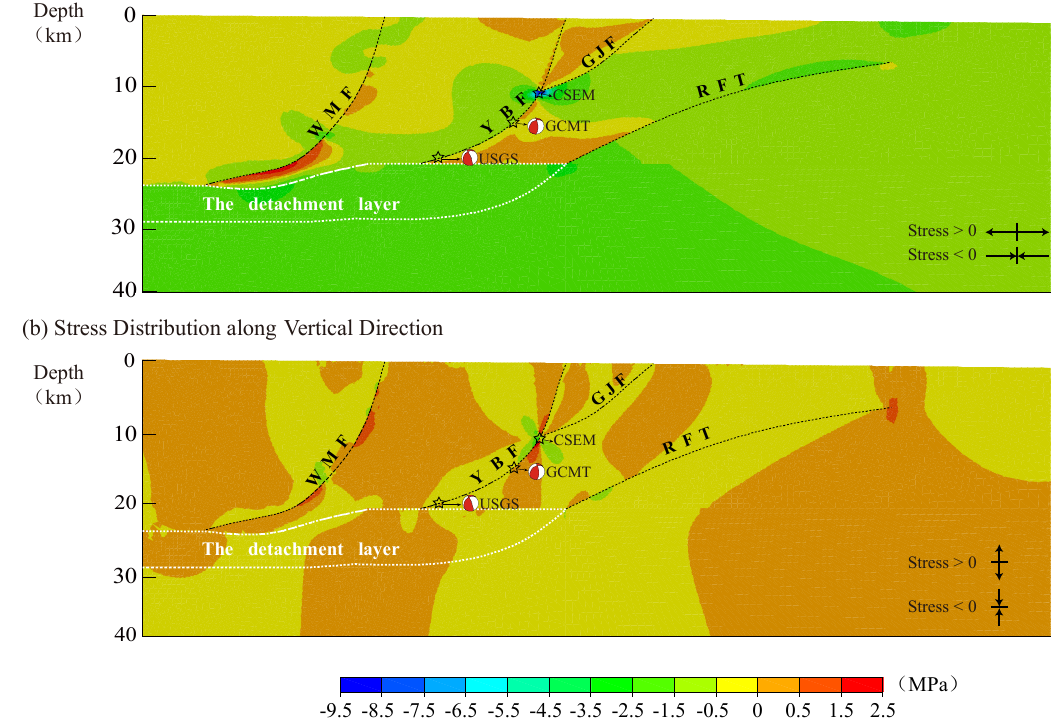
Figure 9. Distribution of equivalent stress accumulation along the horizontal and vertical directions in Model 4. ( a ) is the result in horizontal direction. ( b ) is the results in vertical direction; Black dotted lines: Faults considered in the model; White dotted area: The detachment layer; Pentagram: Location of Wenchuan earthquake projected on fault plane; Beach ball: Wenchuan mainshock from GCMT and USGS.